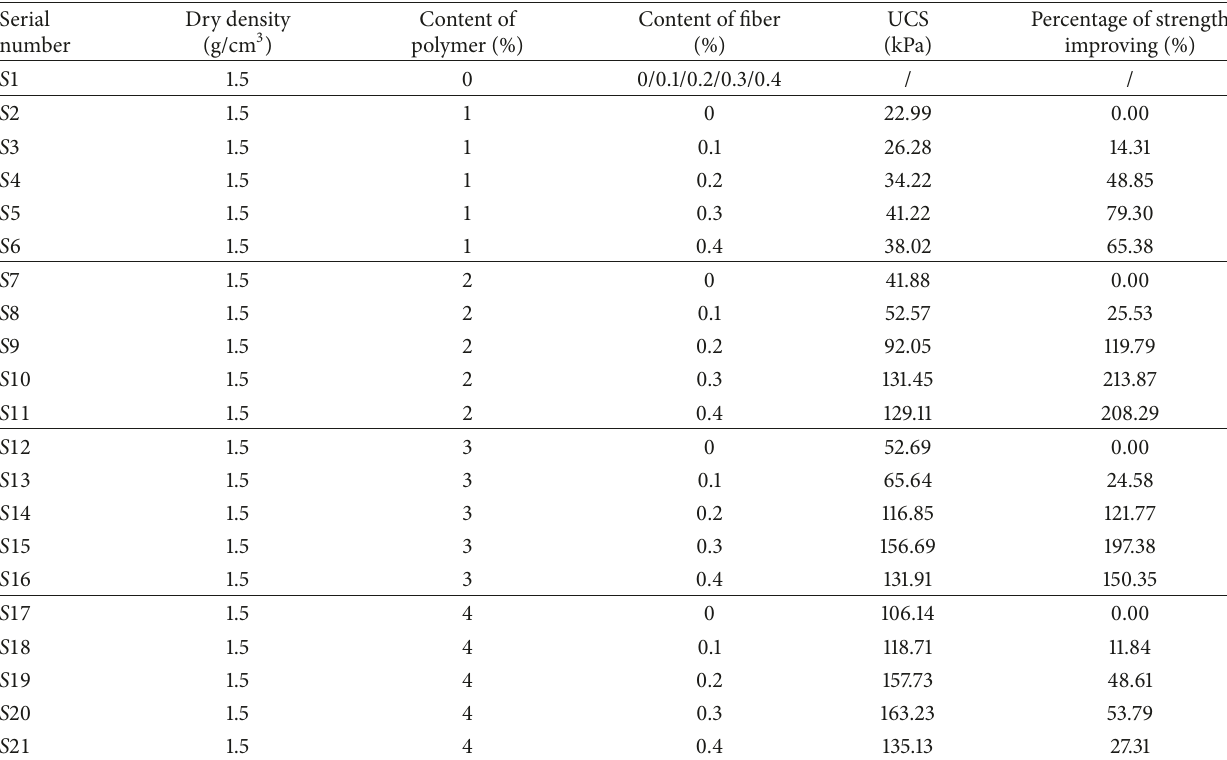
Table 3: Unconfined compressive strengths of sand